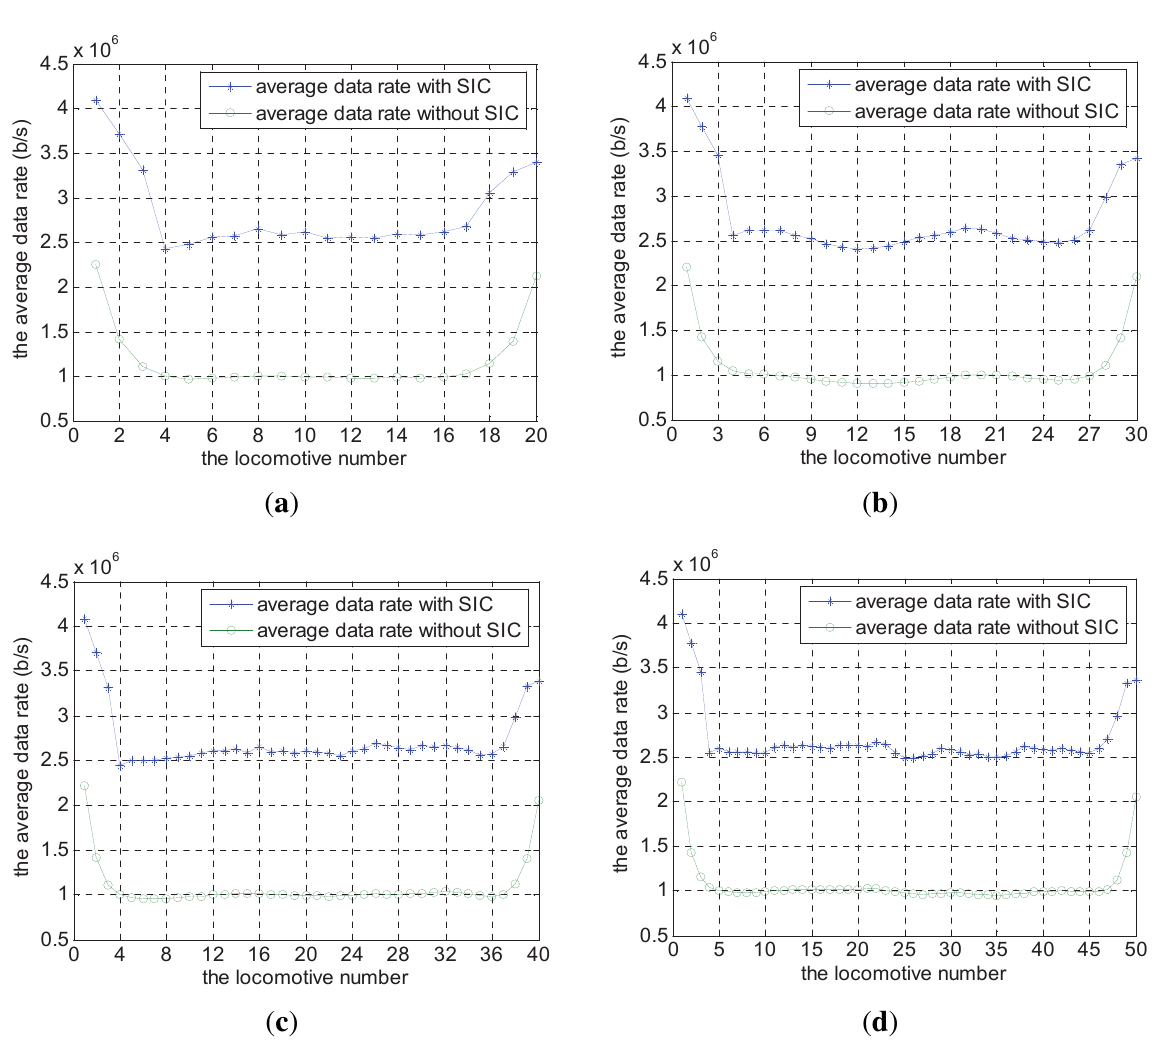
Figure 7. Results for all network instances. ( a ) The number of locomotives is 20; ( b ) The number of locomotives is 30; ( c ) The number of locomotives is 40; ( d ) The number of locomotives is